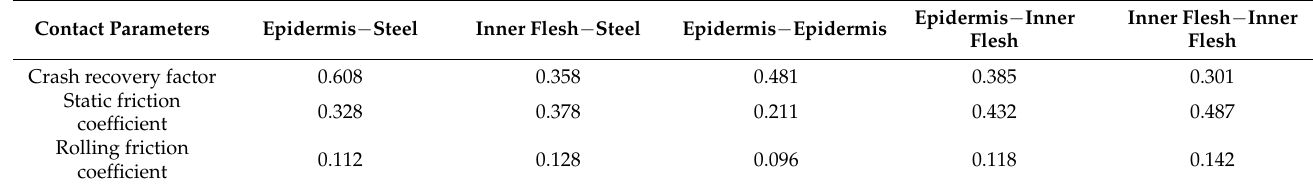
Table 2. Contact parameters of different structures of corn straw.